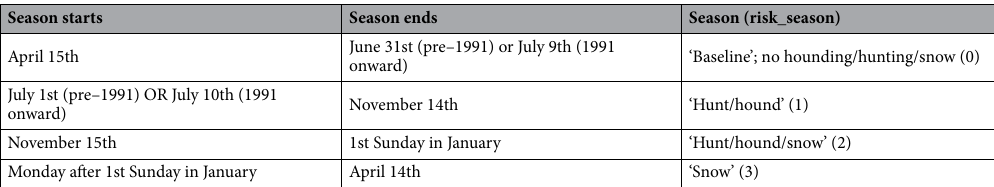
Table 2. Intra-wolf-year (April 15th–April 14th) seasons ( risk_season ) characterized by the absence ( baseline level), presence or overlap of anthropogenic and environmental factors mediating endpoint-specific